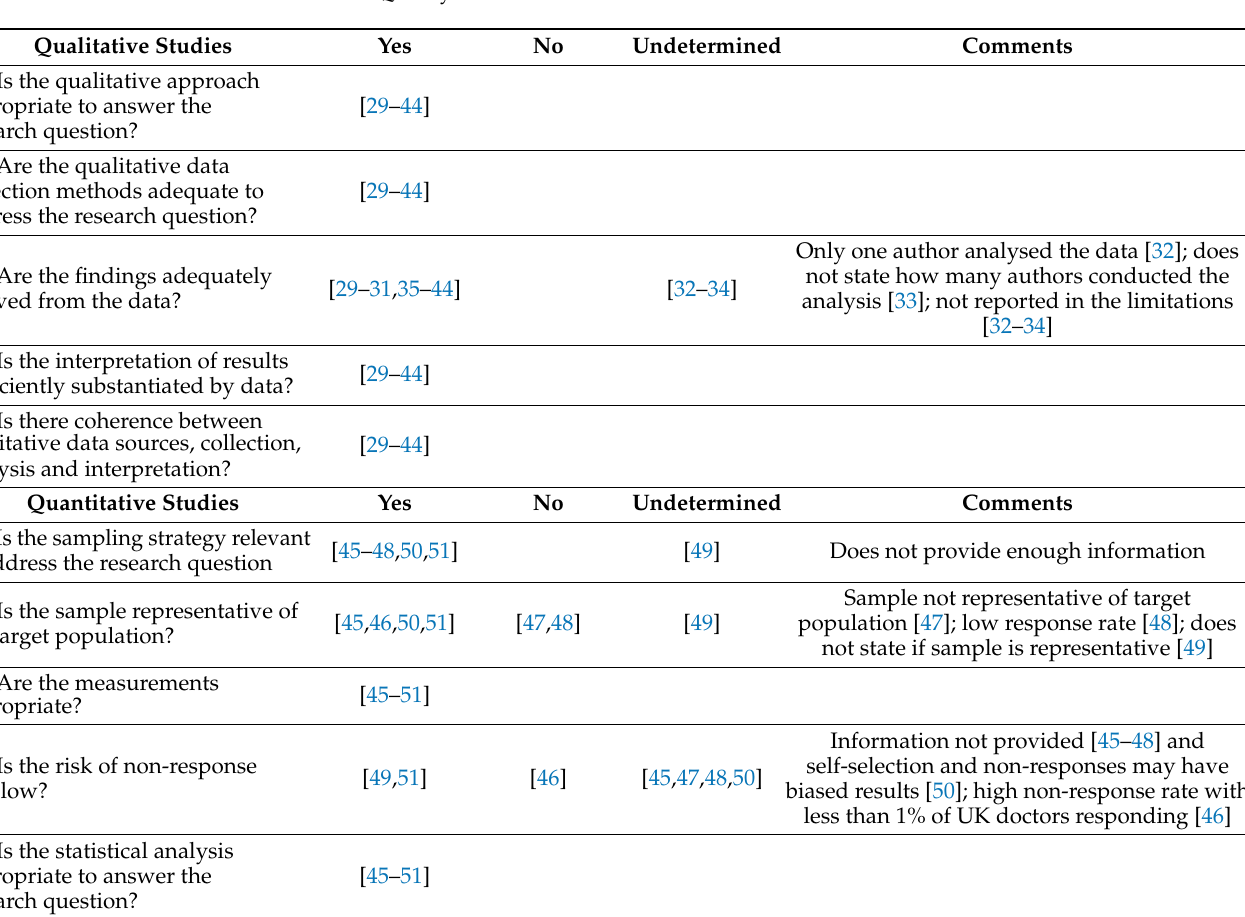
Table A1. Quality Assessment